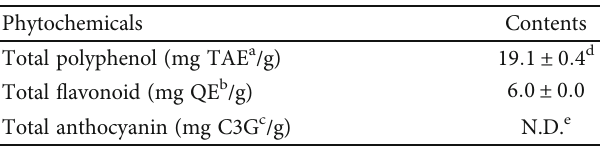
Table 2: Secondary metabolite contents of Commelina communis extract.